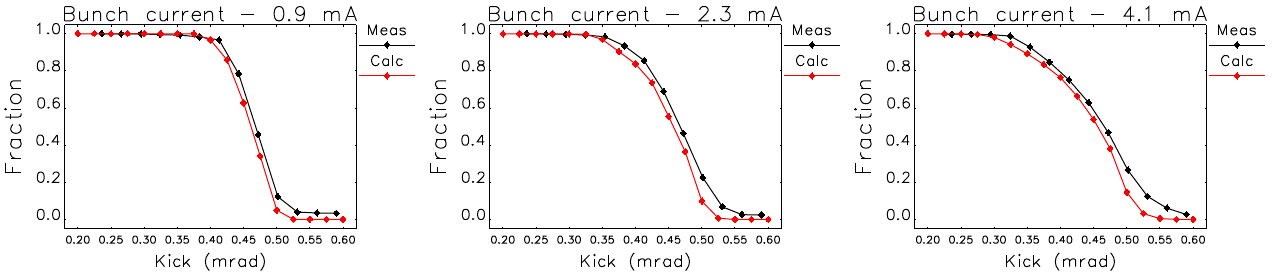
FIG. 6. Comparison of the kick aperture experiment and simulation separately for each bunch charge. The simulation underestimates the dynamic aperture by about 2%. For a given kick, the simulations underestimate the beam losses by about 10%. current monitor, while the sum signal dependence on the coordinate was simply ignored (since the vertical beam motion is much smaller than the horizontal, the vertical BPM sum signal was used). Figure 7 shows comparison of the normalized bunch charge as a function of turns after the kick; lines show simulations and symbols represent mea- surements. While the simulations do not exactly match the experiment, they reproduce the general features, such as the speed of the losses and the steplike behavior. The discrepancy of the remaining charge after the kick approx- imately corresponds to the discrepancy shown in Fig. 6.